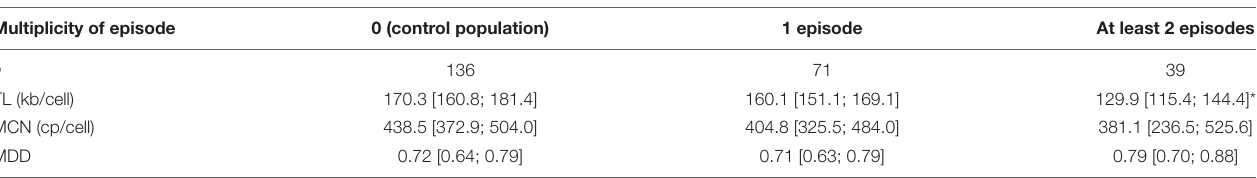
TABLE 4 | Telomere length according to the multiplicity of the MDE, median [95%CI].